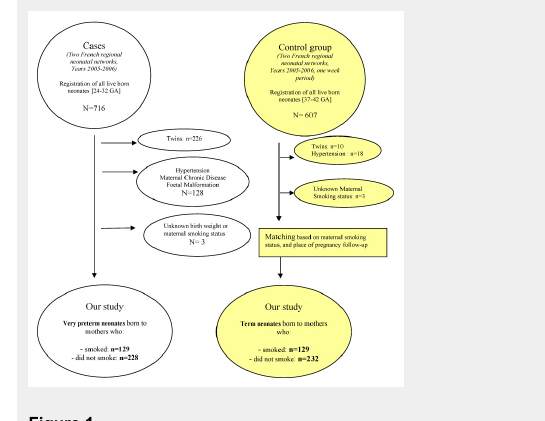
Inclusion and exclusion of cases and control